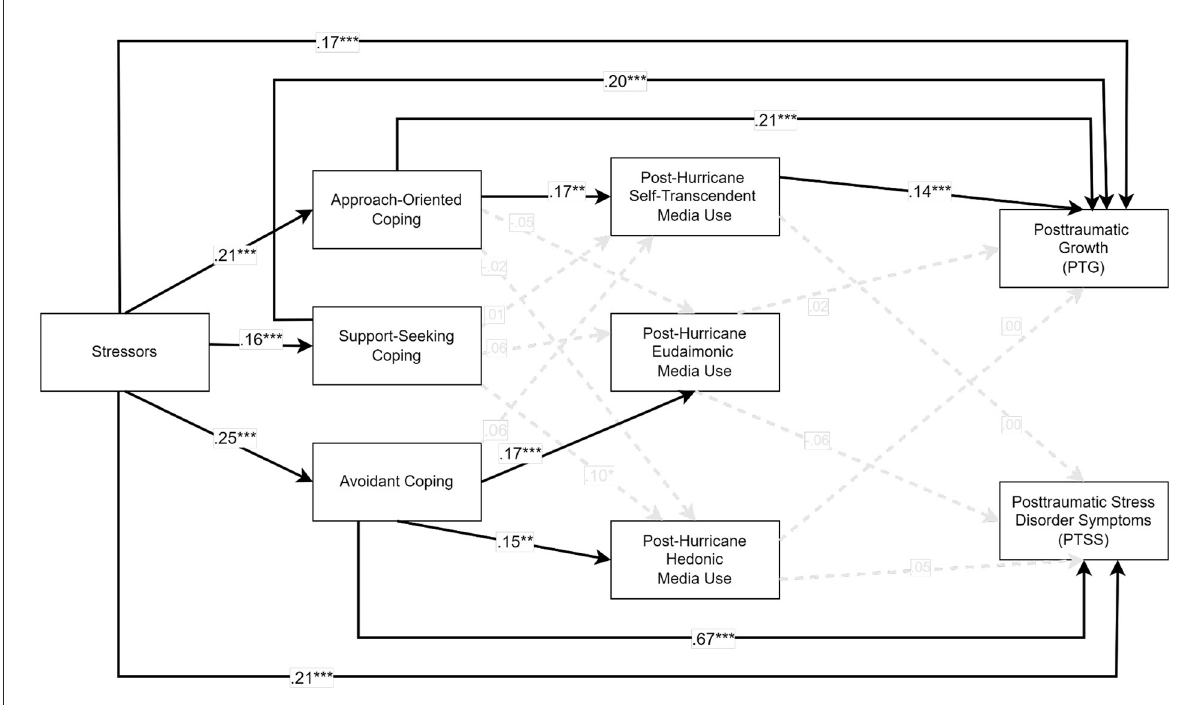
FIGURE2 Final model. This model was associated with a model fit of χ 2 (6) = 10.02, p = 0.12; RMSEA = 0.04 [90% CI: 0.00, 0.08]; CFI = 1.00; SRMR = 0.02. Path coefficients are standardized. ** p < 0.01, *** p <